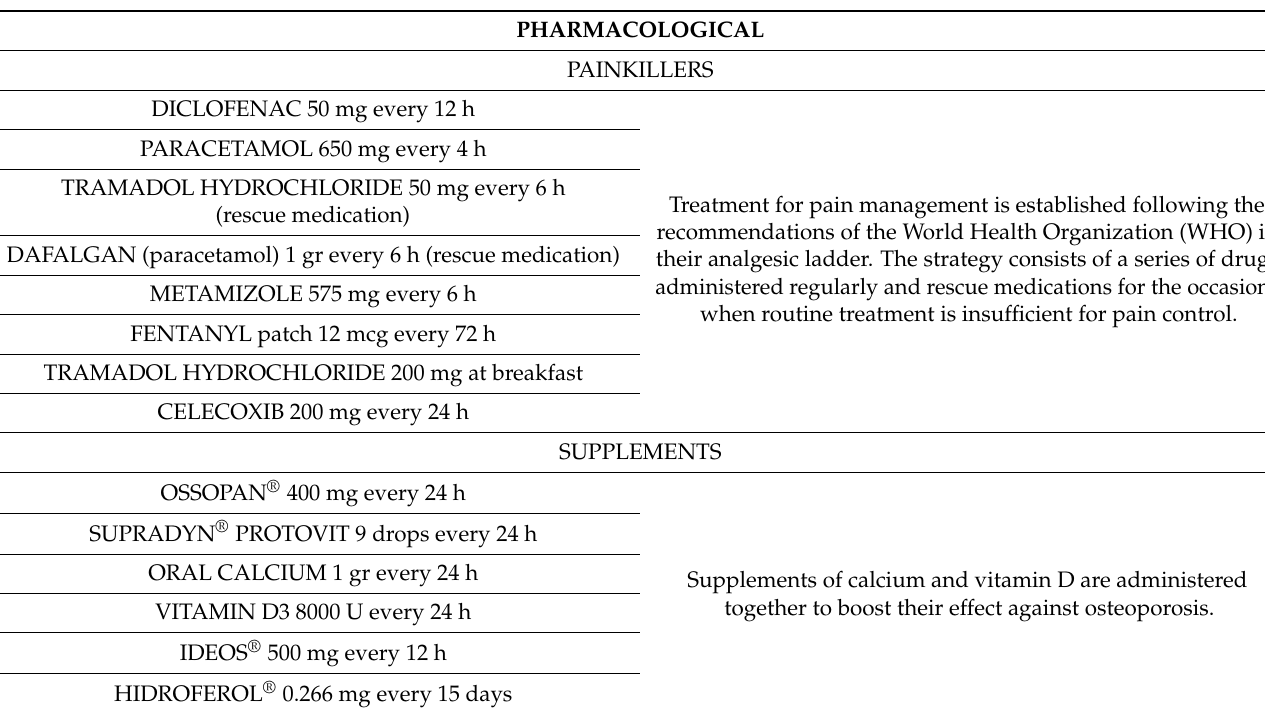
Table 4. Therapeutic